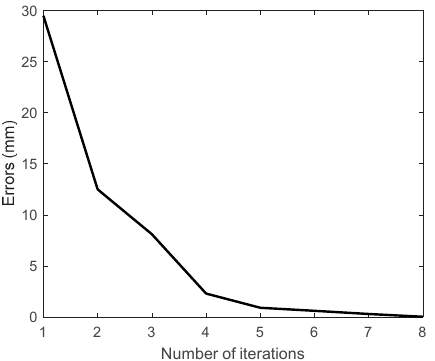
Figure 5. Iteration error versus number of iterations in the simulation.